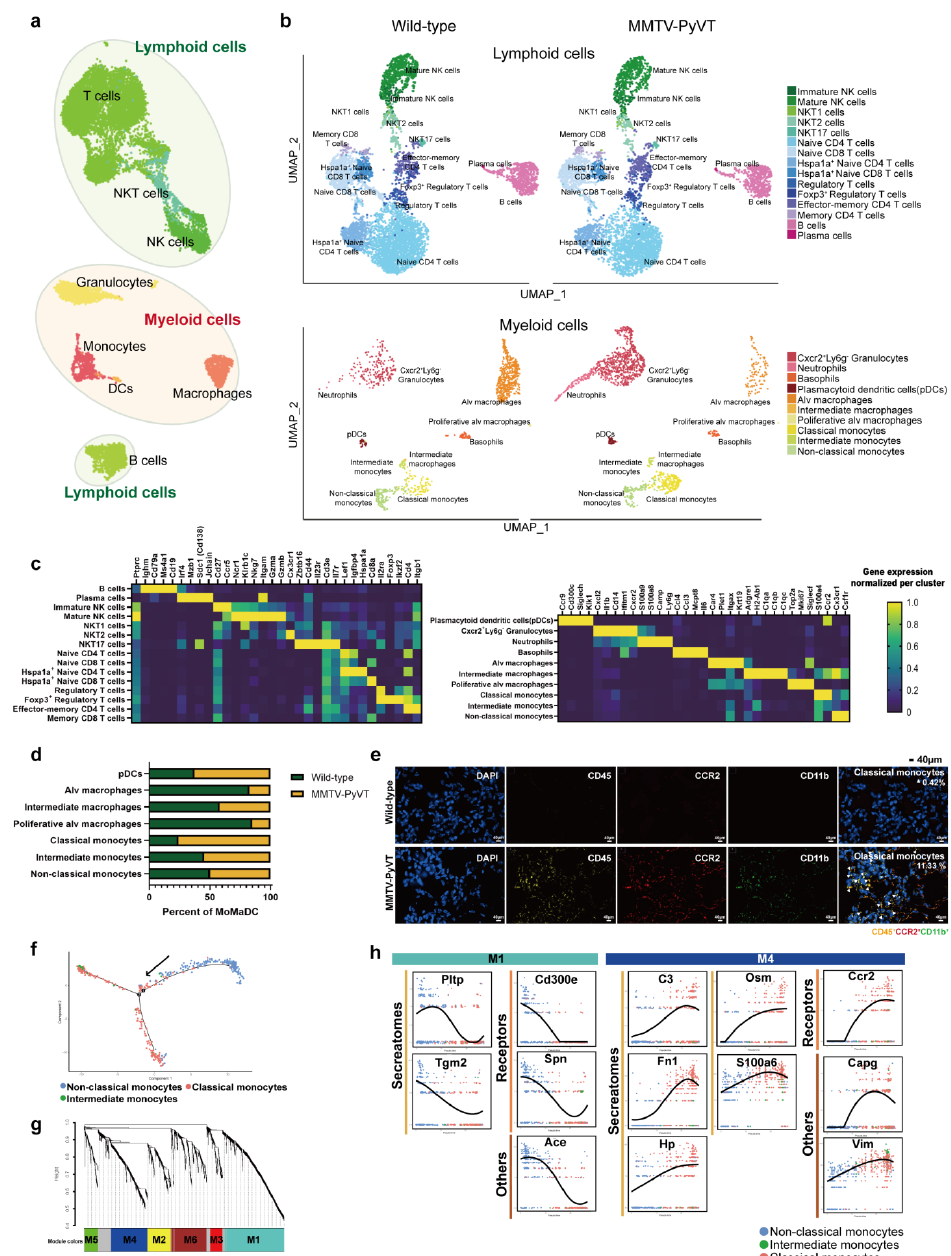
Figure 2. Atlas of immune cells. ( a ) Blueprint of populations of lymphoid and myeloid cells. ( b ) Immune cell (Cd45 + cells) clusters from 10X Genomics scRNA-seq analysis visualized by UMAP. ( c ) The specific biomarkers of each cell cluster. ( d ) The cell number of monocytes/macrophages/DCs. ( e ) Increased cell number was found in the lungs of MMTV-PyVT mice by CODEX Multiplexed Tissue Staining. The lungs of wild-type and MMTV-PyVT mice were collected and stained by CODEX Multiplexed Tissue Staining. Classical monocytes (CD45 + (yellow) CCR2 + (red) CD11b + (green) cells) are indicated by white arrows. The percentage of classical monocytes was indicated as a percentage of total CD45 + cells. Scale bars, 40 µ m. ( f ) Trajectory analysis of monocytes. The trajectory analysis of single-cell data was performed using the Monocle 2 algorithm. ( g ) Analysis of WGCNA. The sequence diagram is shown at the top of the image. The bottom of the figure showed the different color gene modules and the number of bases they contained. ( h ) Genes contributing to the functional differences in non-classical and classical